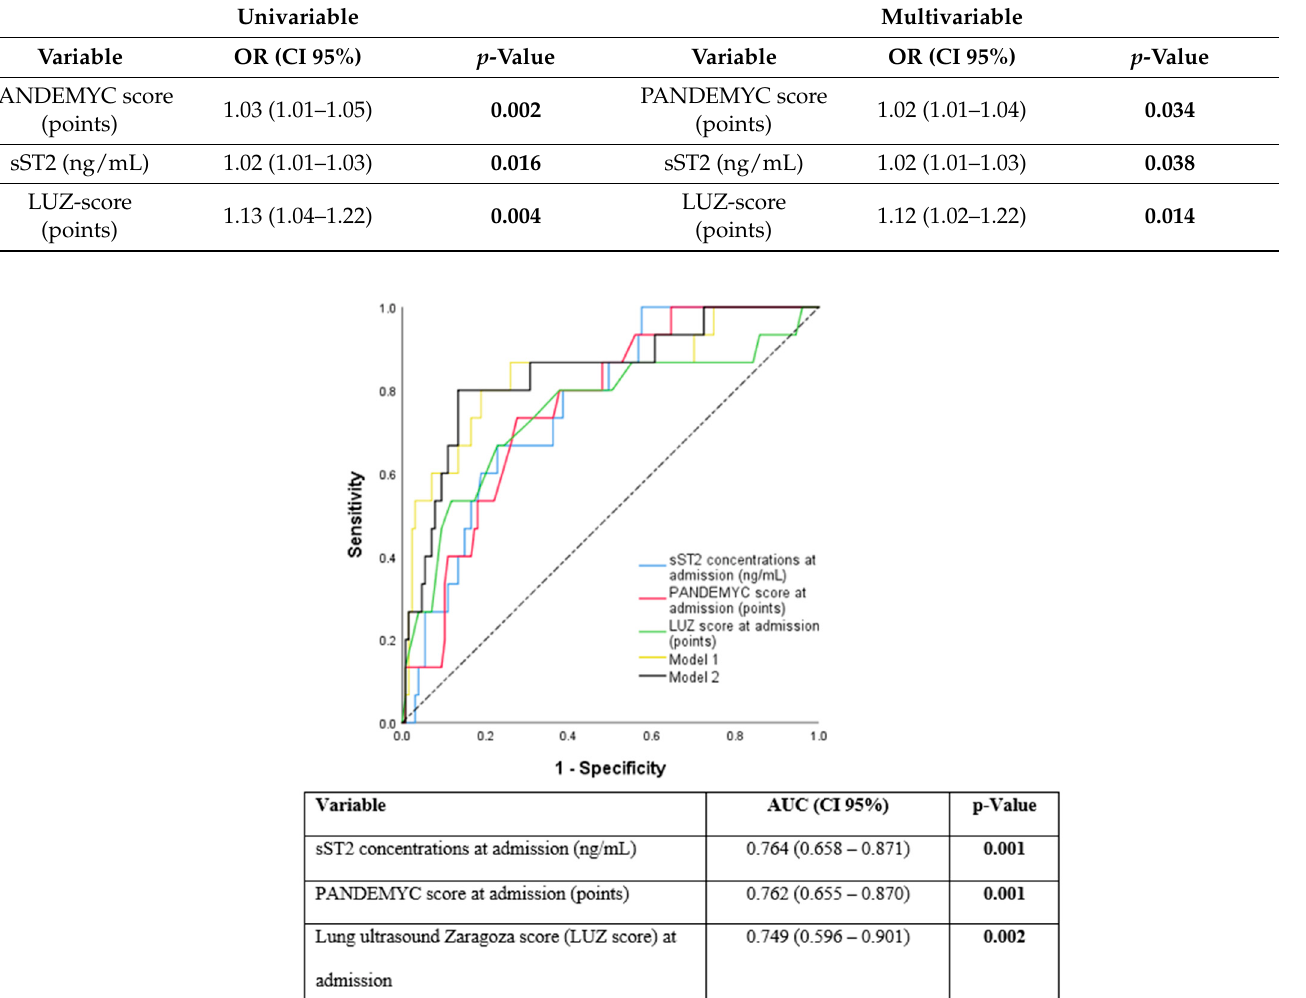
Table 2. Univariable and multivariable logistic regression analysis for the primary endpoint (in-hospital death and/or need for ICU admission for mechanical ventilation).